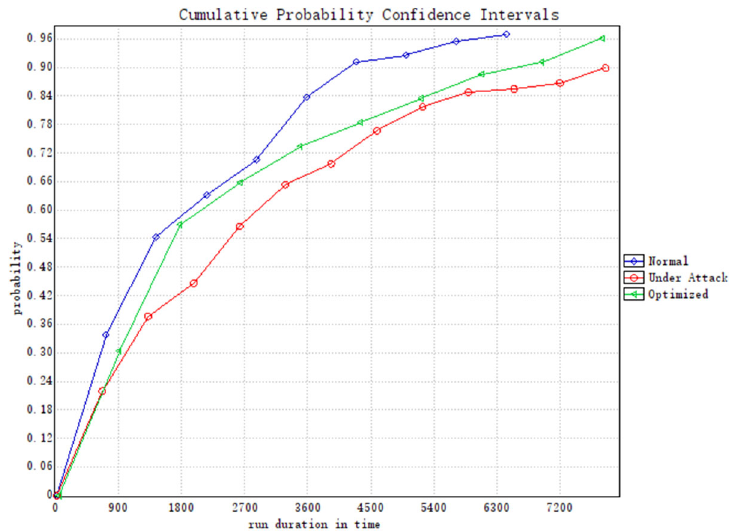
Figure 14. Cumulative probability of the successful response rate in the three scenarios.